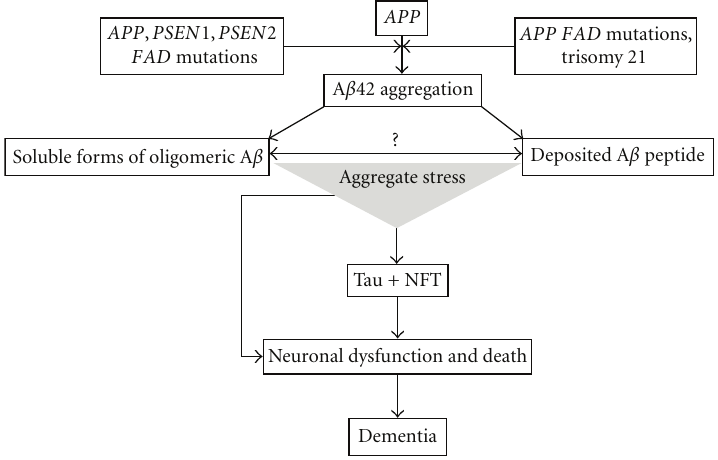
Figure 1: Amyloid cascade